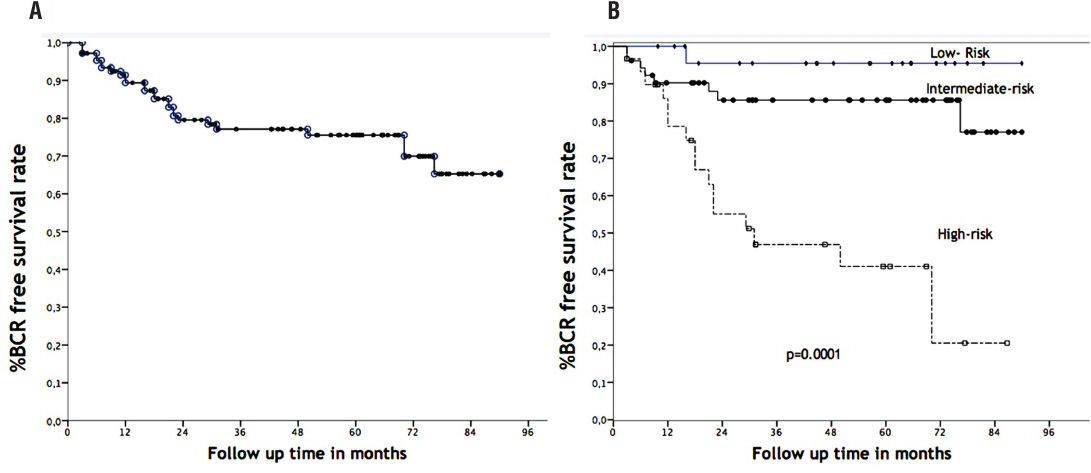
Figure 1 - Biochemical recurrence free survival for the entire cohort (a) and biochemical recurrence for the risk groups